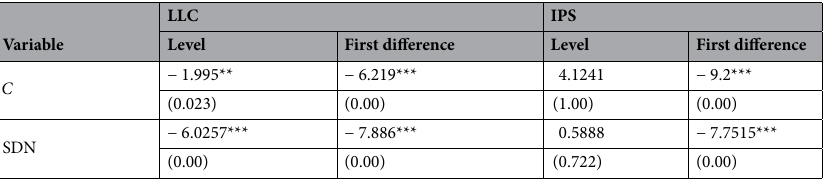
Table 2. Results for the panel unit root tests. (1) Values in parentheses are the p-values. LLC denotes the Levin, Lin, and Chu t test; IPS denotes the Im, Pesaran, and Shin Wald statistic test. (2) The LLC and IPS tests for all of the series include an intercept term. (3) ** and *** denote the null hypotheses of a unit root at the 5% and 1% significance level, respectively. (4) SDN denotes the sum of digital number.